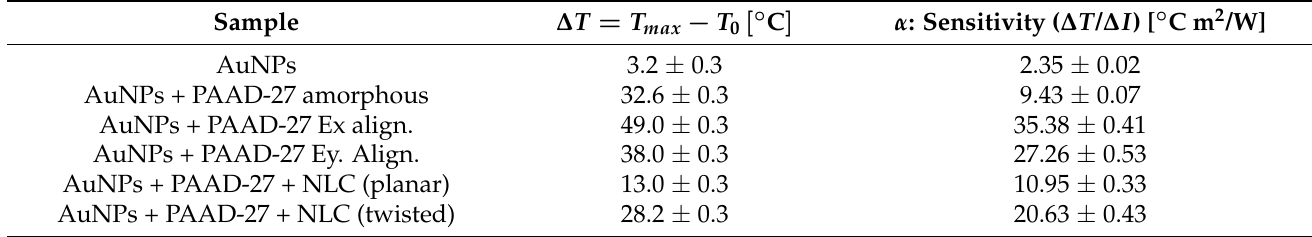
Table 1. Maximum temperature variation ∆ T of the samples and the corresponding